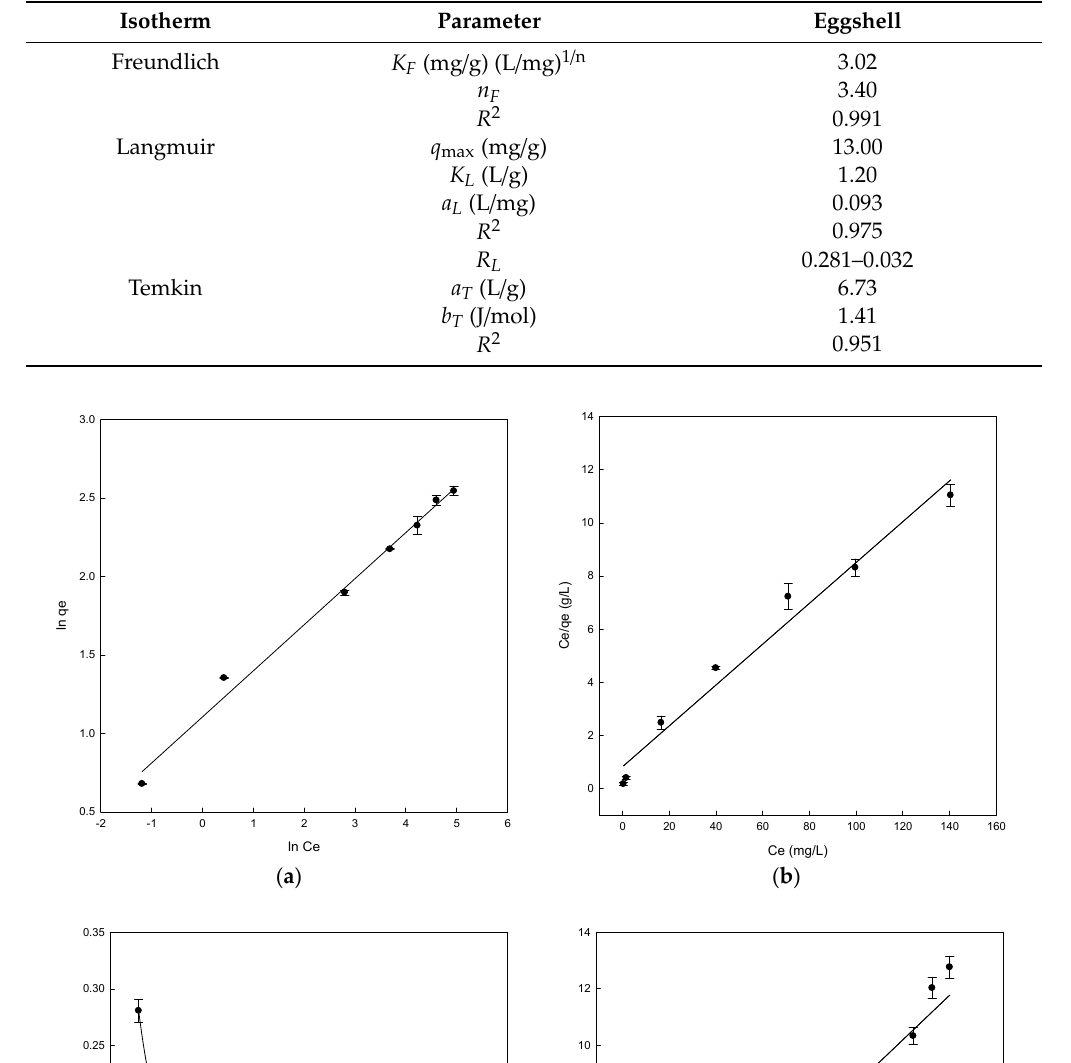
Table 2. Adsorption isotherm constants obtained for eggshell adsorbent.